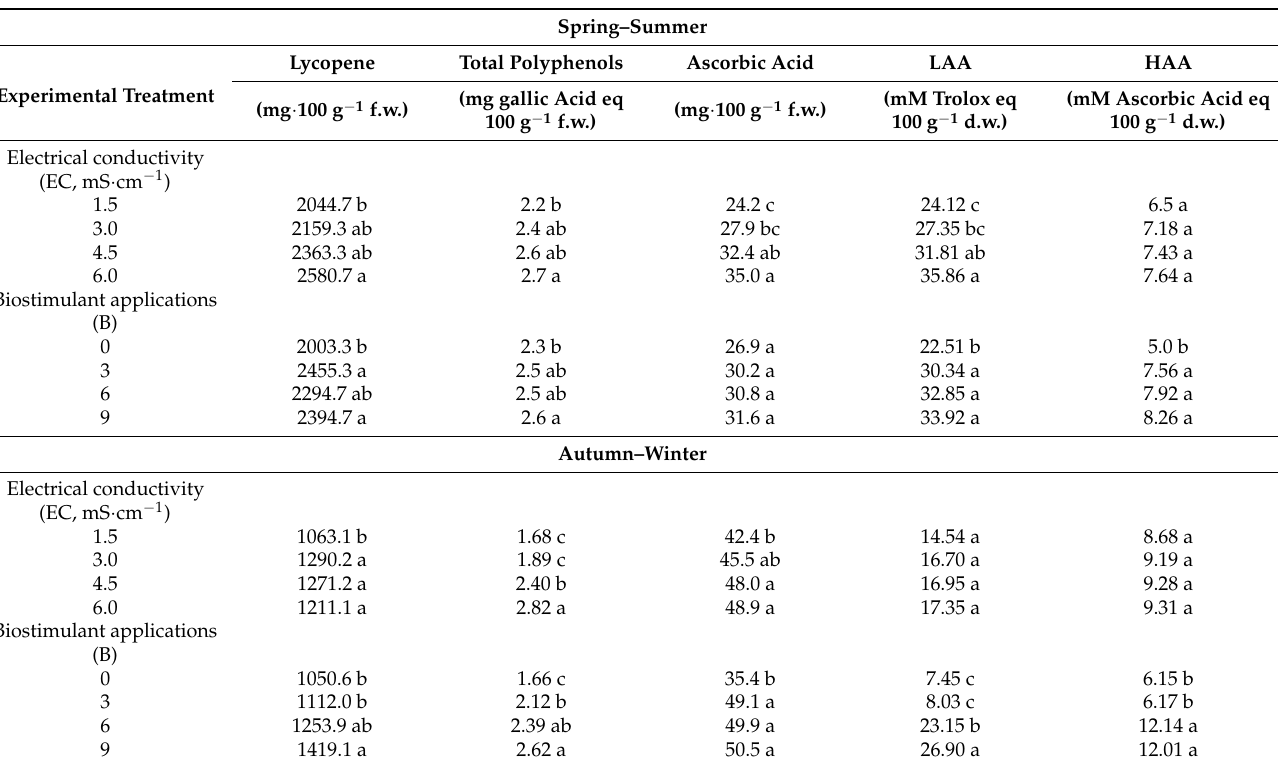
Table 4. Antioxidant compounds and activities of tomato fruits as affected by soil EC and the number of biostimulant